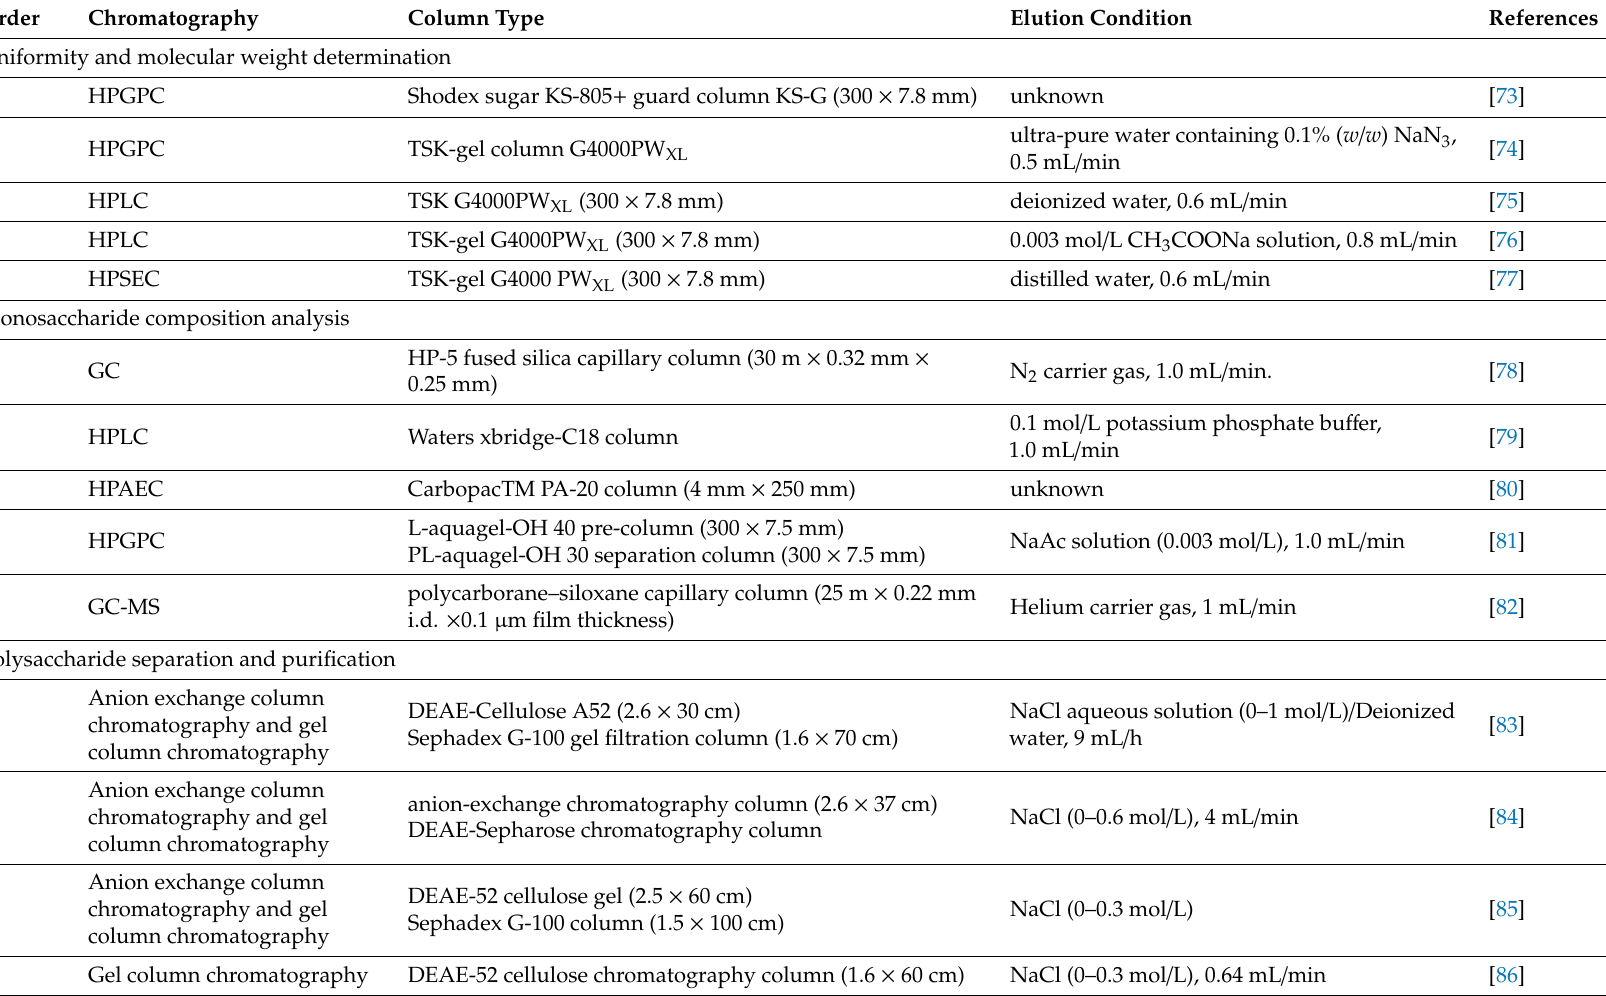
Table 2. Summary of chromatography application in natural